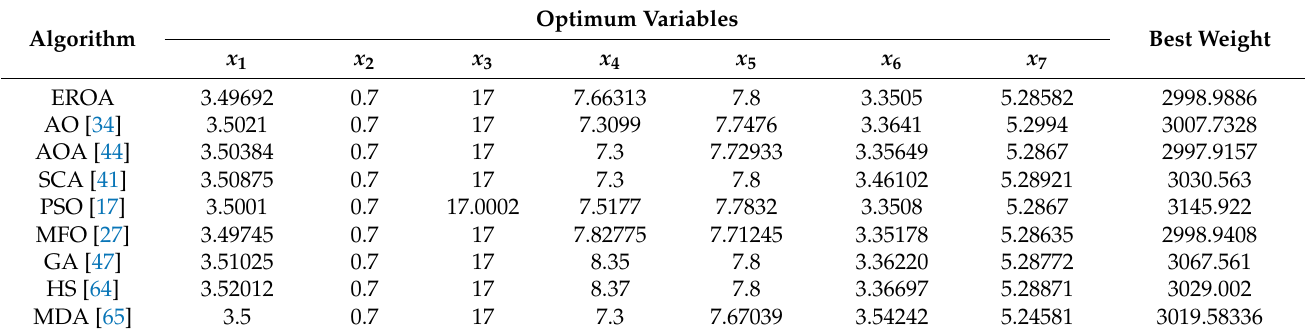
Table 10. Optimization results for the the speed reducer design problem.